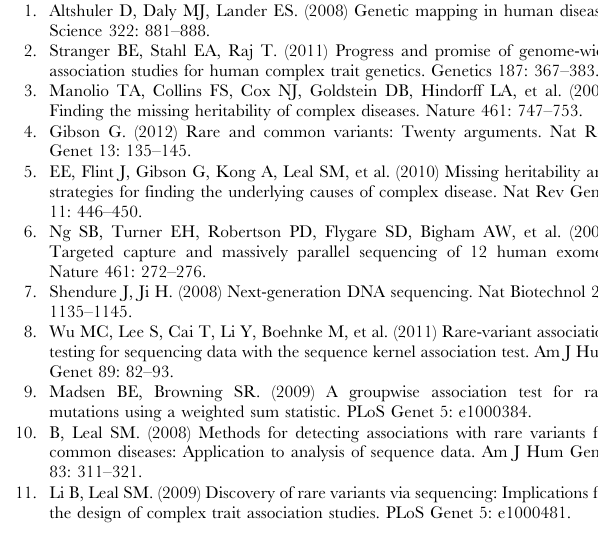
Figure S10 The relationship between a mutation’s effect on the trait and its allele frequency. Statistics were calculated for each simulation replicate and then averaged over the 1000 simulation replicates. ( A, C ) A SNP’s effect on the trait is correlated with its effect on fitness ( t = 0.5). ( B, D ) A SNP’s effect on the trait is